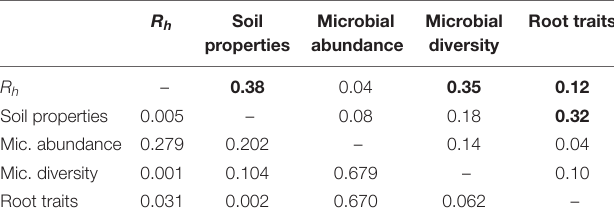
TABLE 3 | RV coefficients (top right of table) between groups of abiotic and biotic environment variables and heterotrophic respiration ( R h ) from multiple factor analysis ( Figure 3